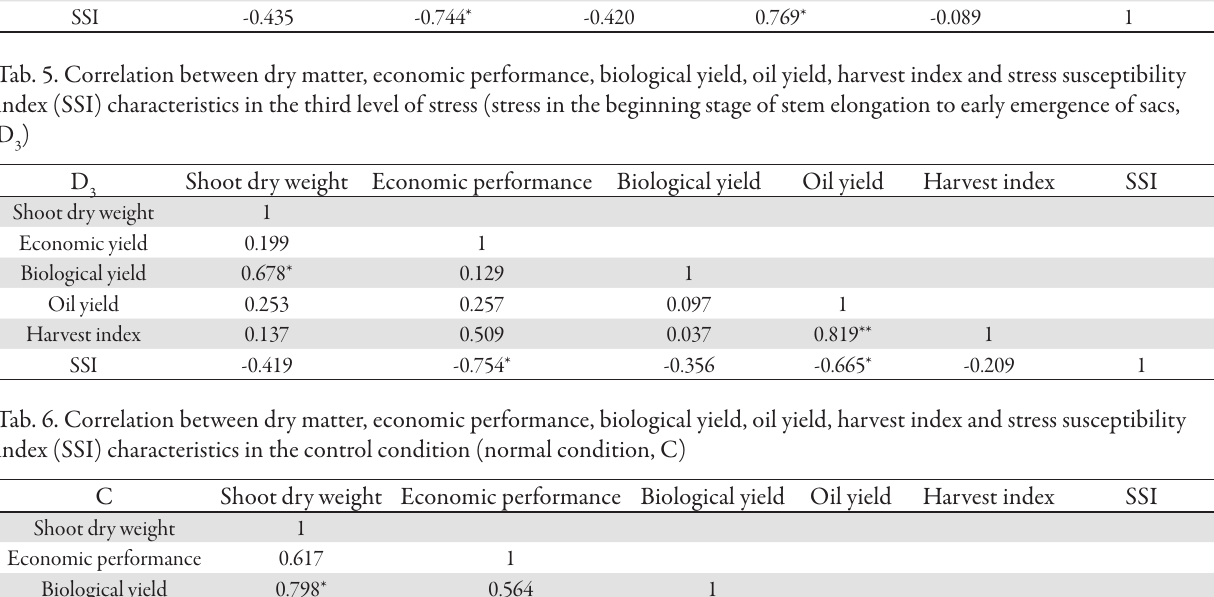
**: Significant at 1% Probability level; *: Significant at 5% Probability